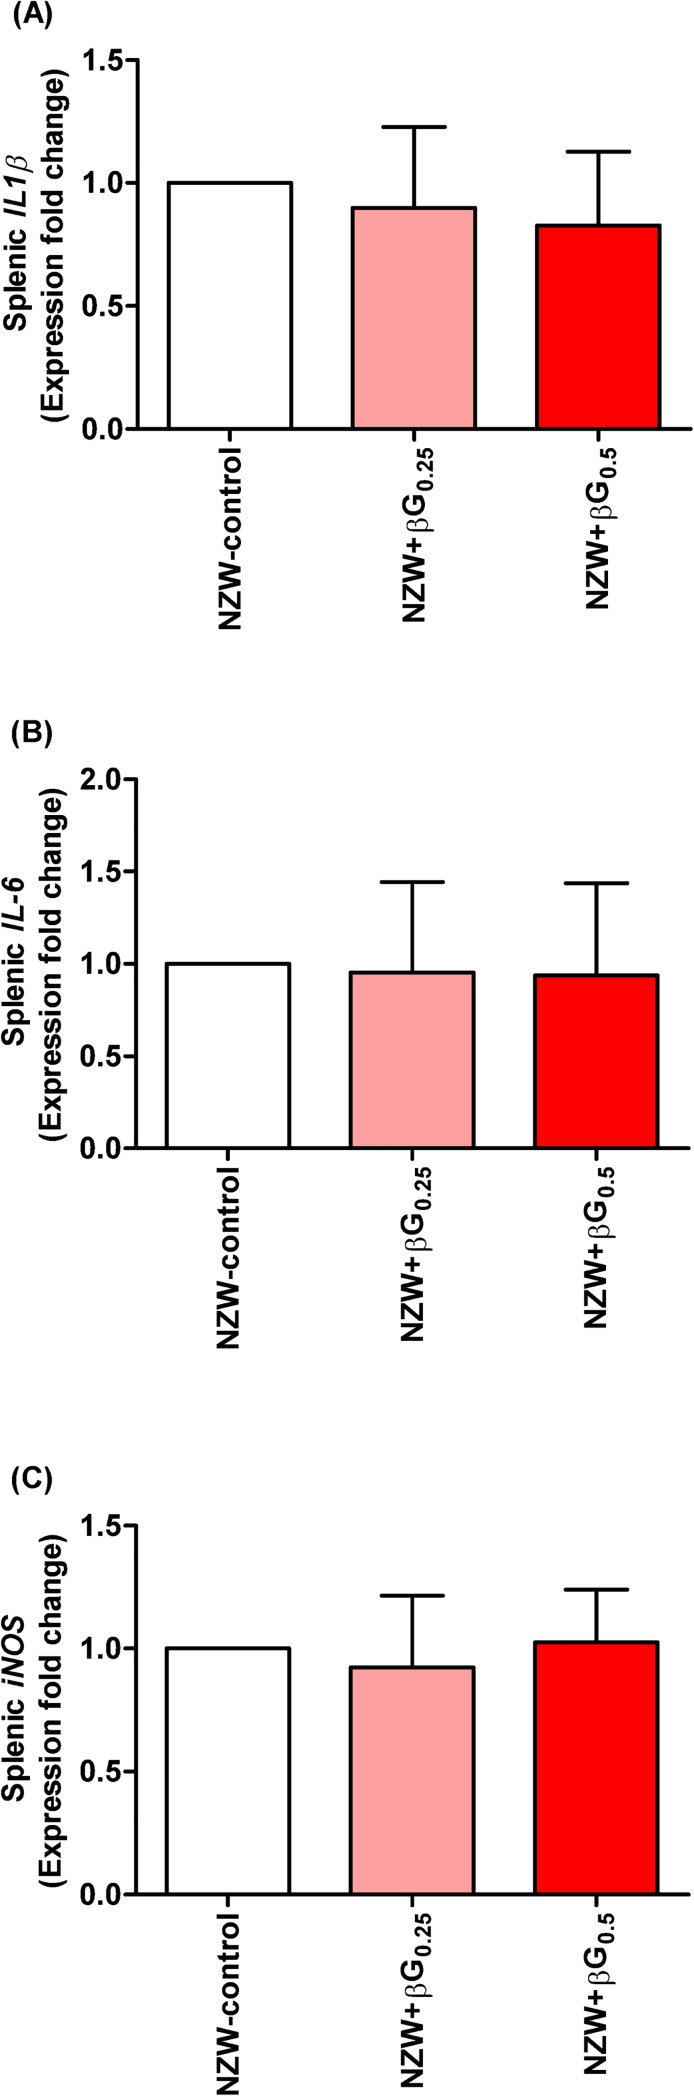
RT-PCR validation of the splenic (A) interleukin-1beta (IL1β), (B) interleukin-6 (IL-6), and (C) inducible nitric oxide synthase (iNOS) genes in NZW rabbits. Statistical analysis was performed using one-way ANOVA and Tukey's post hoc test for multiple comparisons.